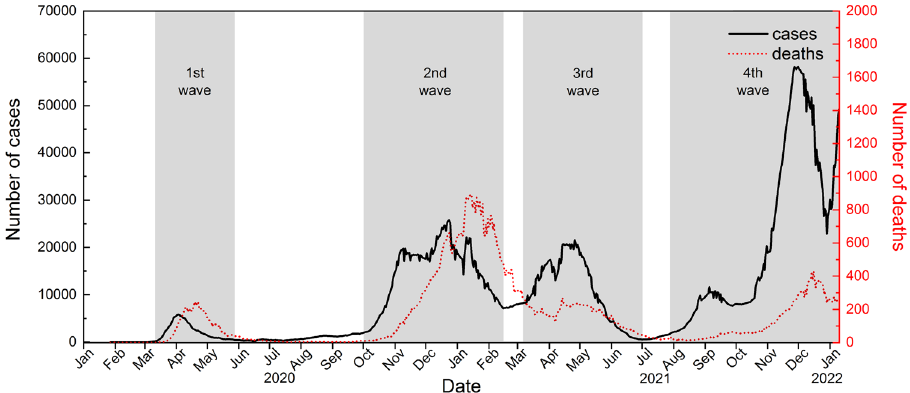
Figure 2. Seven-day moving average of daily numbers of confirmed cases and deaths in Germany from 27 January 2020 to 7 January